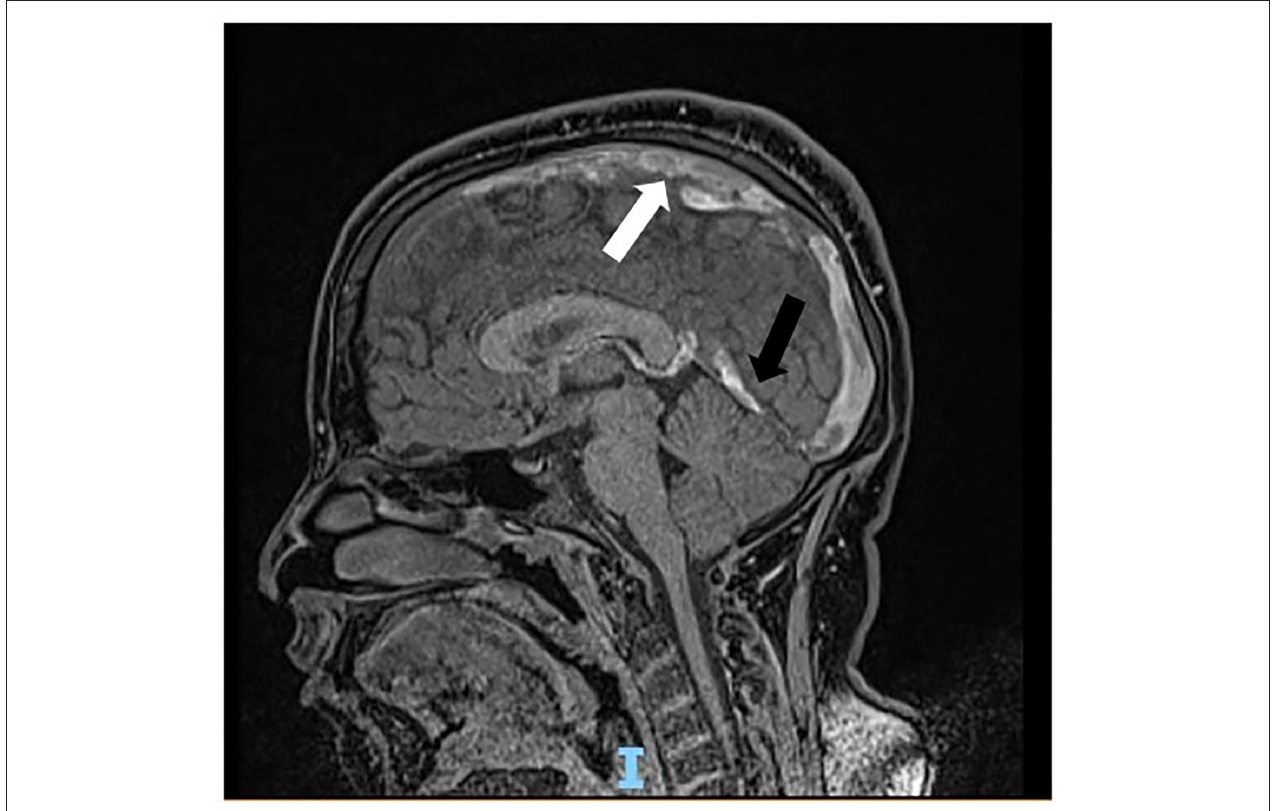
FIGURE 2 | Sagittal scan of magnetic resonance showing thrombosis cast of the superior sagittal sinus (white arrow) and transverse-sigmoid sinuses (black